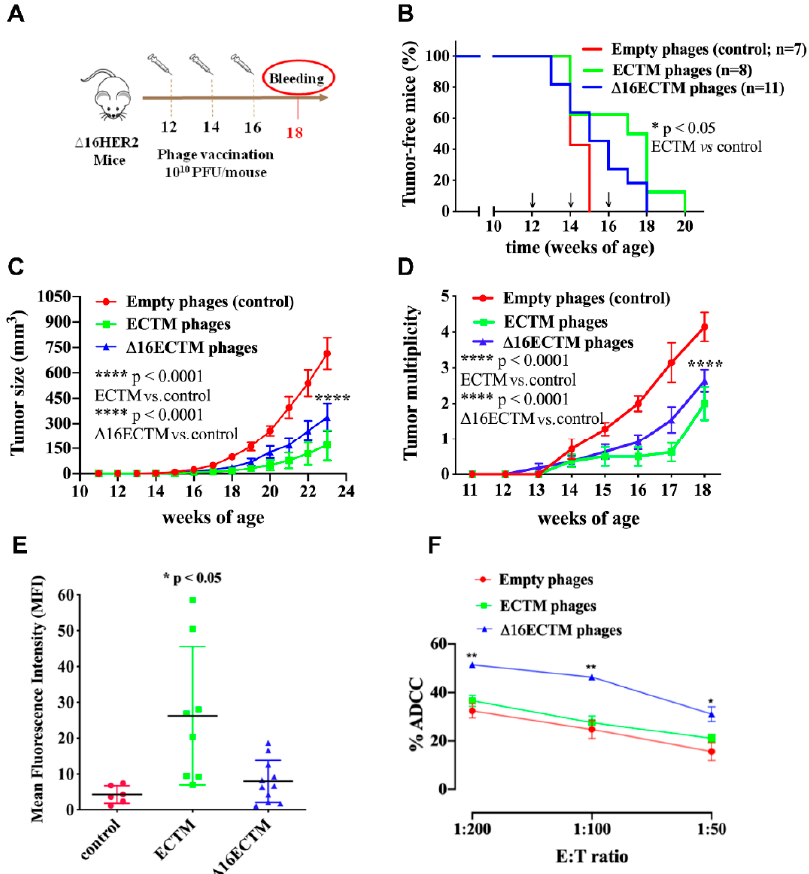
Figure 3. Phage-based vaccination against HER2+ BC in a therapeutic experiment. ( A ). 10 10 (PFU/mouse) ECTM- or Δ 16ECTM- or empty-phage (control) vaccines were administered to ∆ 16HER2 mice at 12, 14 and 16 weeks of age (n = 7–11 mice per group). Bleeding occurred at the 18th week of age for sera analysis of anti-HER2-antibody titer. ( B ). Kaplan–Meier curves; Log Rank test (* p < 0.05 ECTM vs. empty phages). ( C ). Tumor growth curves; Two-way ANOVA with Tukey’s multiple comparison test (**** p < 0.0001 control vs. ECTM; **** p < 0.0001 control vs. Δ 16ECTM). ( D ). Tumor multiplicity curves; Two-way ANOVA with Tukey’s multiple comparison test (**** p < 0.0001: ECTM vs. empty phages; Δ 16ECTM vs. empty phages). ( E ). Antibody detection. Sera of mice (n = 7–11 mice per group) were analyzed by FACS using Δ 16HER2-HEK293 cells; data represent Mean fluorescence intensity (MFI) ± SD; Student’s t -test (* p < 0.05 control vs. ECTM). ( F ). ADCC assay was performed using CAM6 target cells incubated with a 1:50 dilution of sera from vaccinated mice (n = 3) and splenocytes as effector cells at different effector/target cells ratios (200:1, 100:1 and 50:1). Results shown are the mean ± SEM of the percentage of ADCC induced by different sera; Student’s t -test (* p < 0.05; ** p < 0.01).